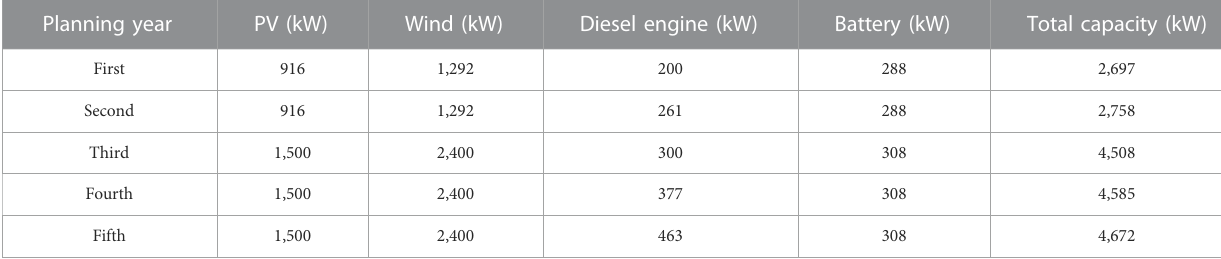
TABLE 5 Cost of buying power for the industrial microgrid from the main grid (Yona et al., 2007).